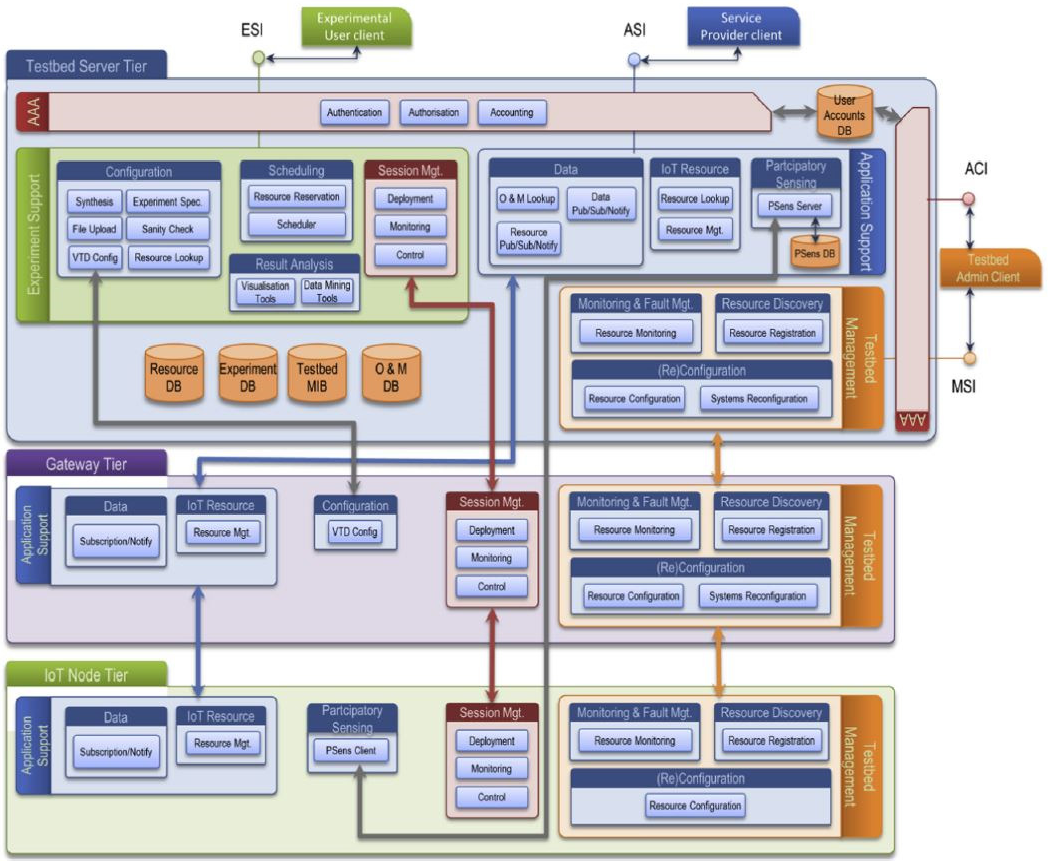
Figure 21. SmartSantander Smart City architecture [66].